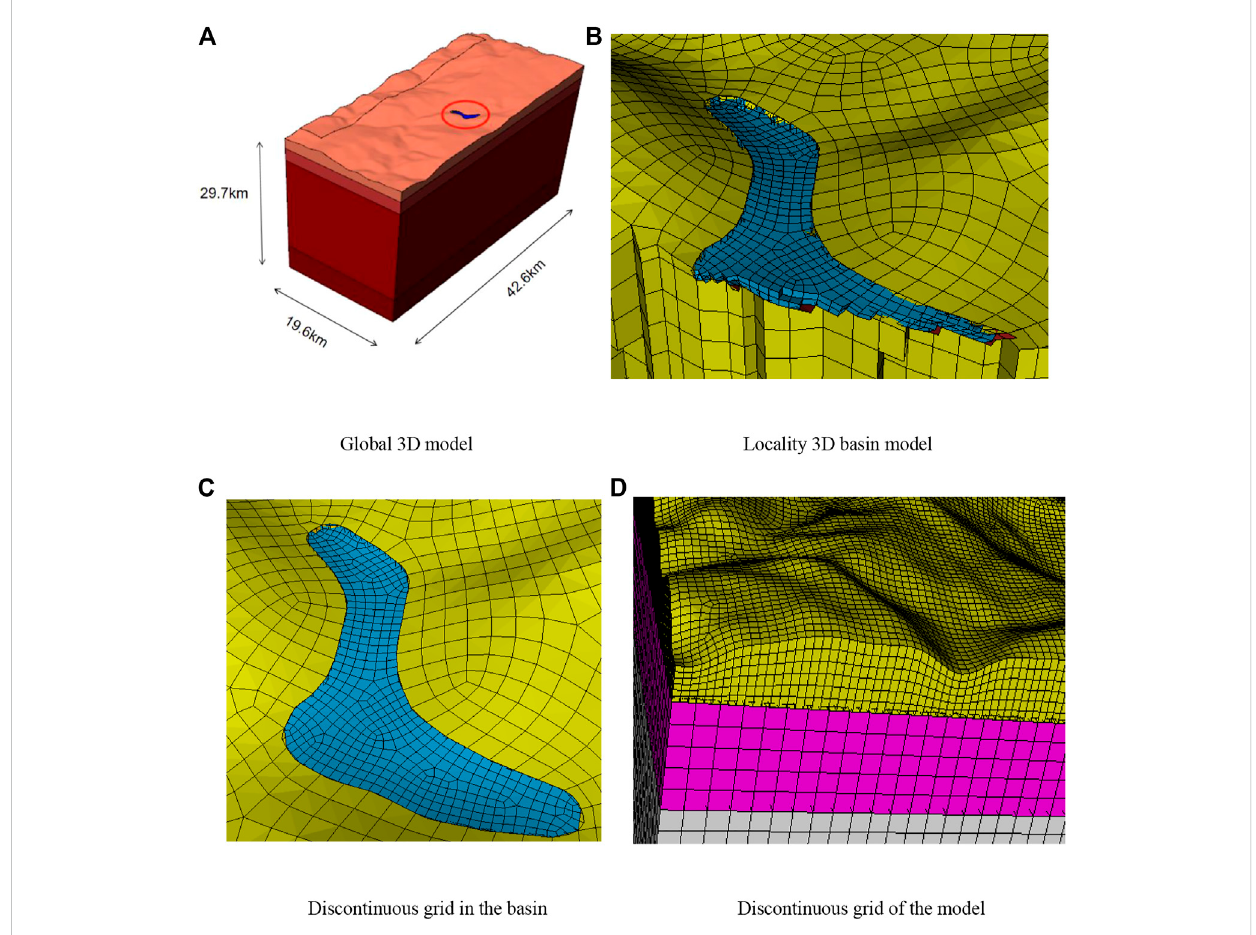
FIGURE 4 3D computational model of the 2014 M6.5 Ludian – Longtoushan Basin earthquake. (A) Global 3D model. (B) Locality 3D basin model. (C,D) Discontinuous grid in the